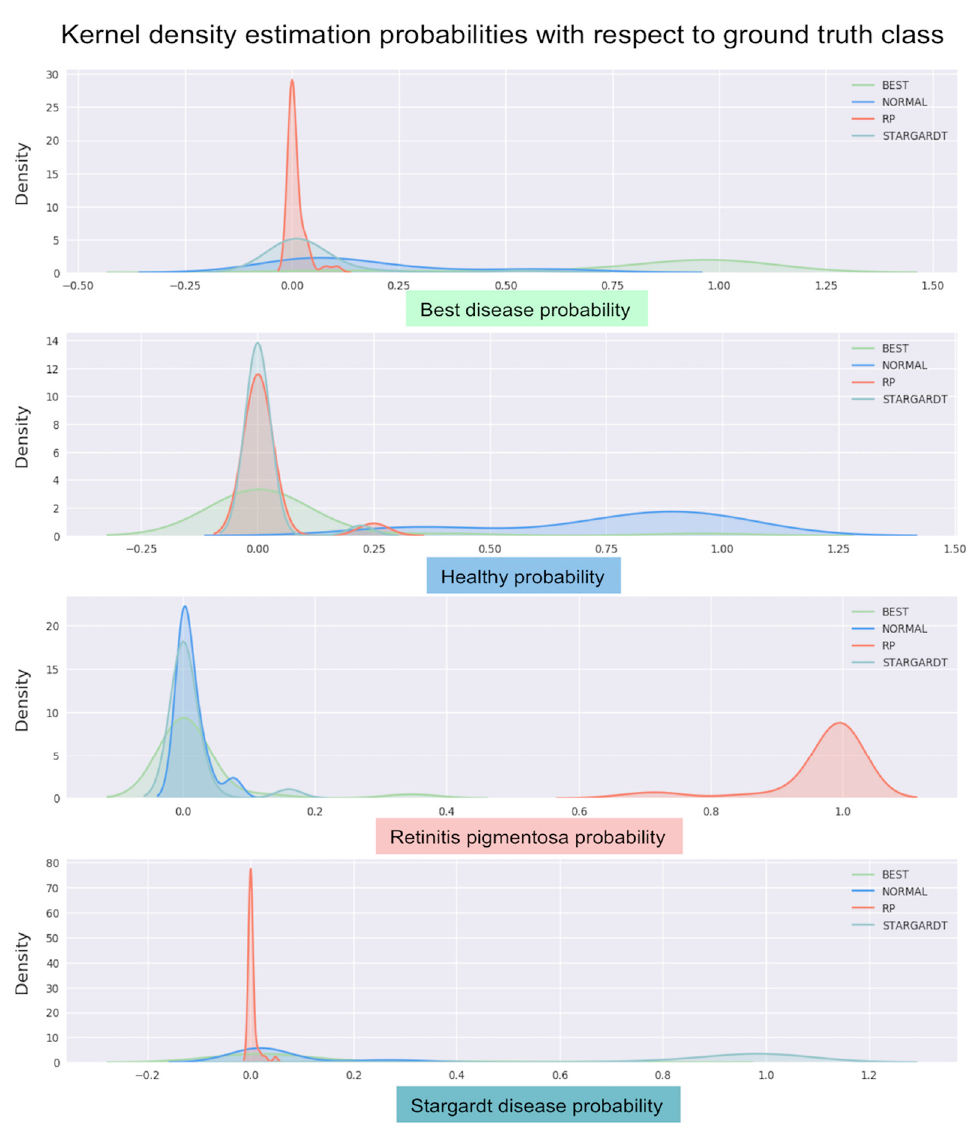
Figure 6. Kernel density estimation (KDE) graphs showing the estimated probability for each of the four classes: upper panel, Best disease KDE; second panel, healthy control KDE; third panel, retinitis pigmentosa KDE; and fourth panel, Stargardt disease KDE. The deep learning model generates a probability for the affiliation of each image of the test dataset to one of the four classes. The images are then compared to each ground truth class to which they were originally assigned, leading to four different KDE graphs. A peak towards 1 corresponds to FAF images for which the probability of the predicted class coincides with the tested ground truth class, while a peak towards 0 corresponds to FAF images for which the probability for the tested ground truth class is low and is, therefore, not likely to correspond to the studied ground truth class.